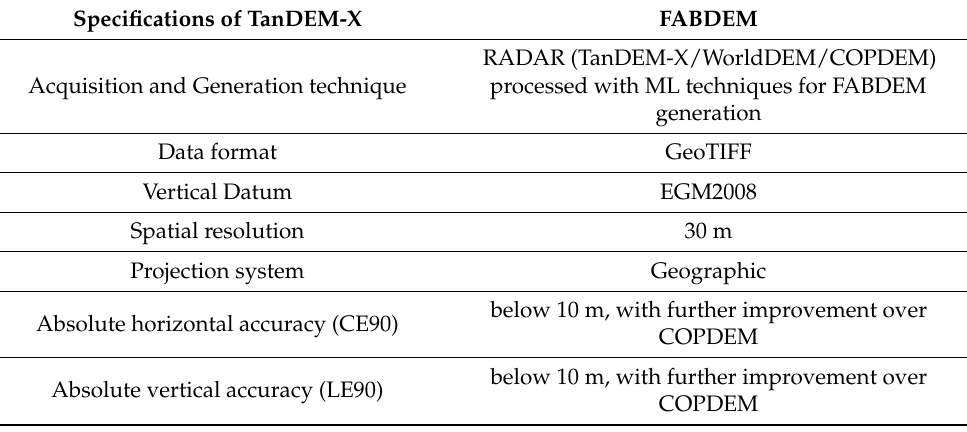
below 10 m, with further improvement over